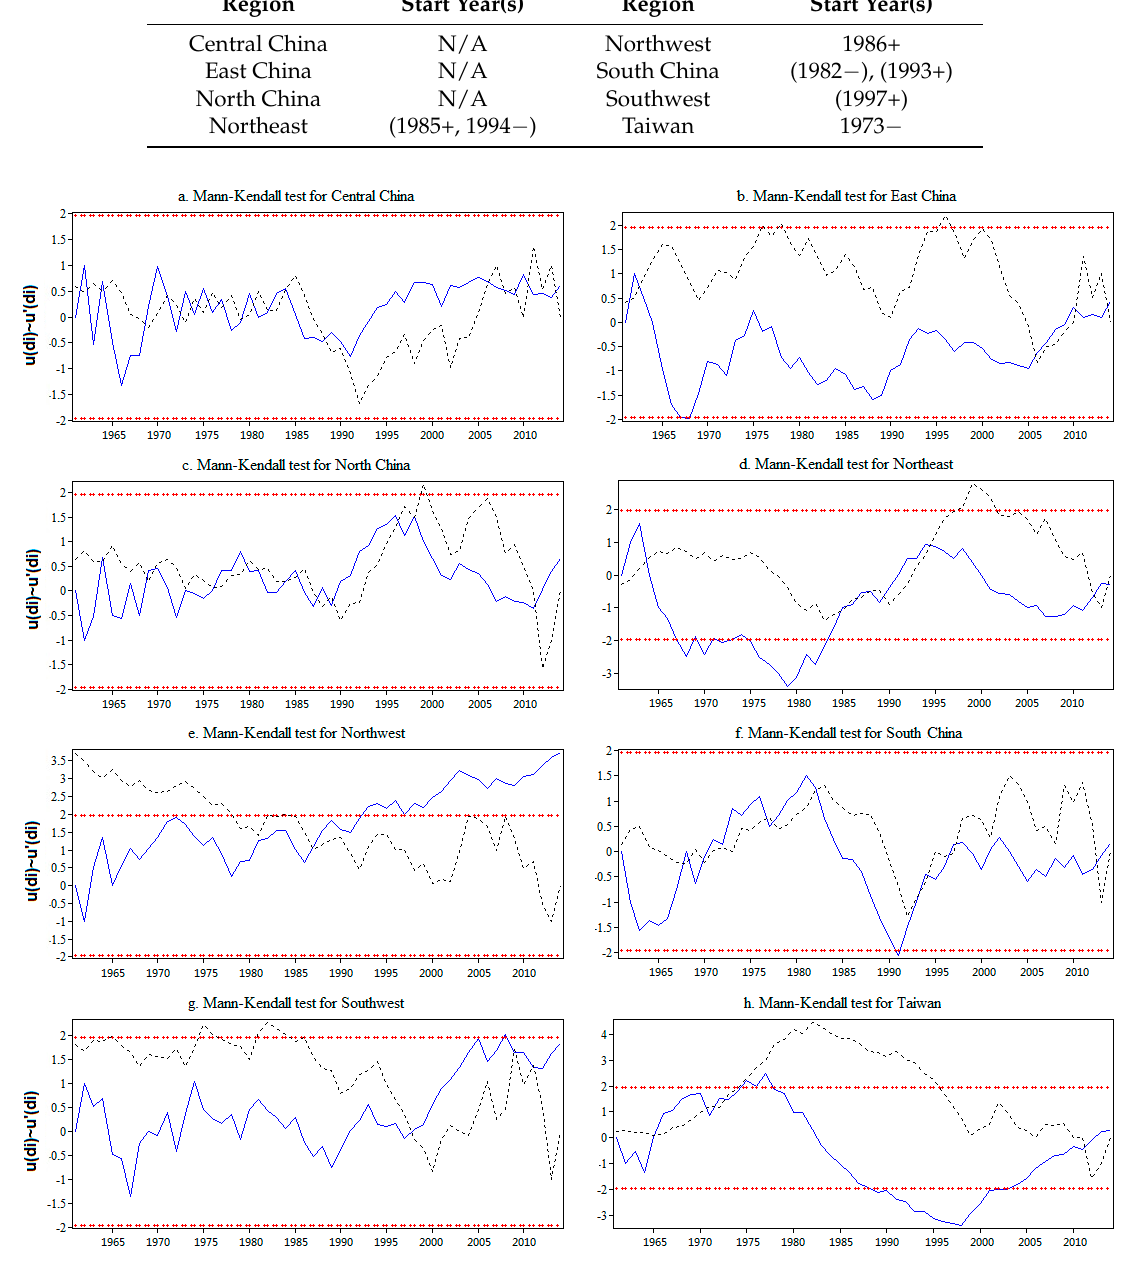
Figure 6. Sequential Mann-Kendall test for SPI time series from 1961 to 2014 in ( a ) central China; ( b ) east China; ( c ) north China; ( d ) northeast; ( e ) northwest; ( f ) south China; ( g ) southwest; ( h ) Taiwan. Blue line denotes SPI progressive series, black dotted line is retrograde series, red dotted line indicates 95% confidence interval (u = 1.96 or u = − 1.96).